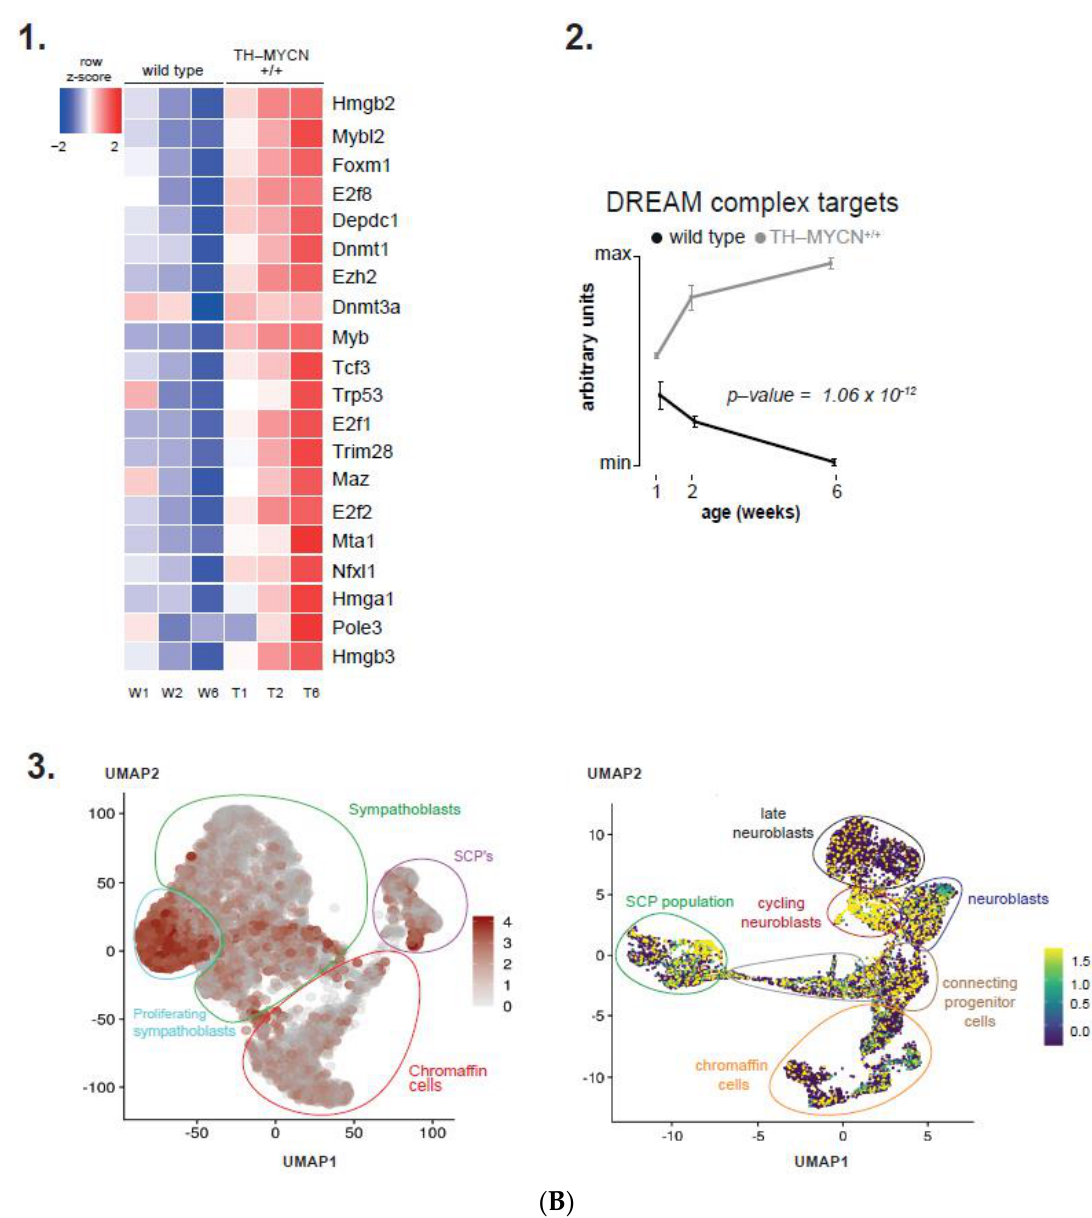
Figure 6. Identification of the DREAM complex and HMGB2 as key putative master regulators of TH-MYCN driven neuroblastoma tumorigenesis. ( A ) VIPER-inferred master regulators for neuroblastoma development. Each transcription factor regulon is indicated by a red and blue vertical bar, showing the distribution of activated (red) and repressed (blue) targets of each transcription factor ranked by differential expression in TH-MYCN +/+ versus wild-type mice upon 6 weeks after birth. The enrichment of each regulon on the neuroblastoma signature is indicated by the associated p -value (left) and normalized enrichment score (NES) (right). The heatmap on the right infers for each transcriptional regulator its differential activity and expression, as well as its rank in the gene expression signature. ( B ) (1) Heatmap representing the expression of the top-20 inferred master regulators after reranking according to differential expression from Weeks 1 to Week 6 after birth in TH-MYCN +/+ versus wild-type mice. (2) Signature score analysis of the DREAM complex targets in the hyperplasia dataset. Data represent mean signature score ± standard deviation of 4 samples. y -axis represents arbitrary units. Gray : TH-MYCN +/+ samples; black : wild type samples. p -value corresponds to the interaction term of a two-way ANOVA analysis. (3) (left) Single-cell analysis of HMGB2 expression in the developing sympathoadrenal lineage points towards expression in the (proliferating) sympathoblasts and SCPs [49] (SCP: Schwann cell precursor); (right) Single-cell analysis of HMGB2 expression in different cell populations of the adrenal medulla shows HMGB2 expression mainly in the neuroblast and SCP population [50].